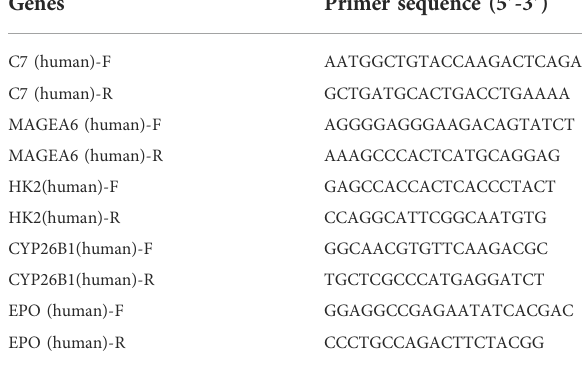
TABLE 1 The primer sequences of the 5 hub